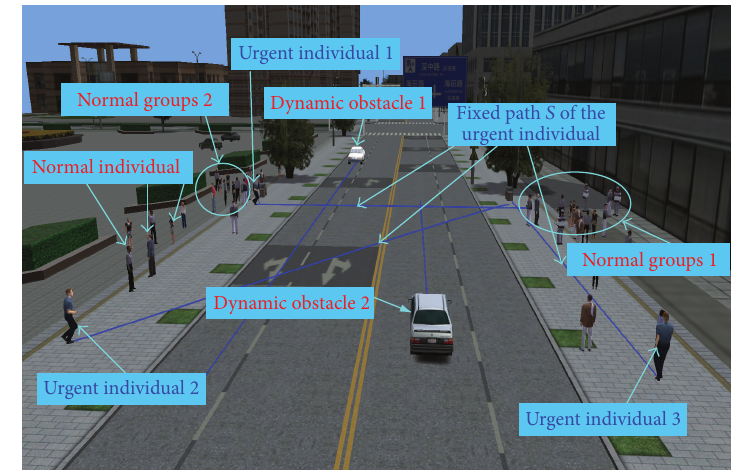
Figure 6: The dynamic environment of the